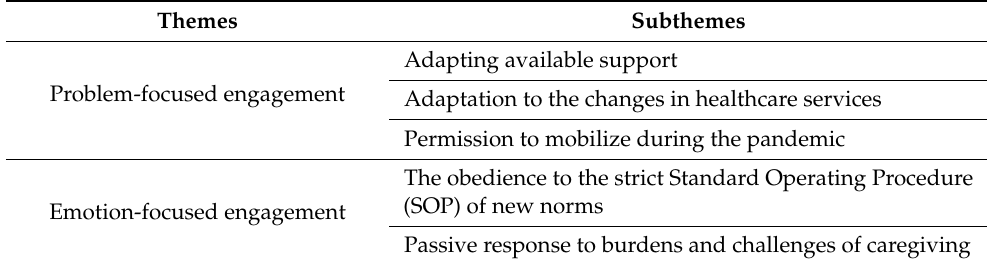
Table 3. Subthemes and themes on coping strategies in managing stroke patients during the pandemic of